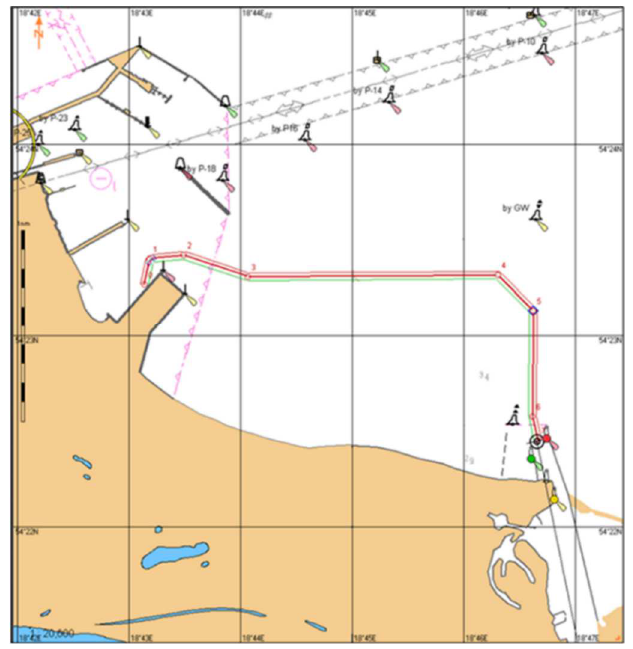
Figure 2. The route planned on the stretch from the first task (from the quay of the container terminal in Gdansk to the mouth of the Martwa Wisła). Source: ECDIS NaviSailor 4000.